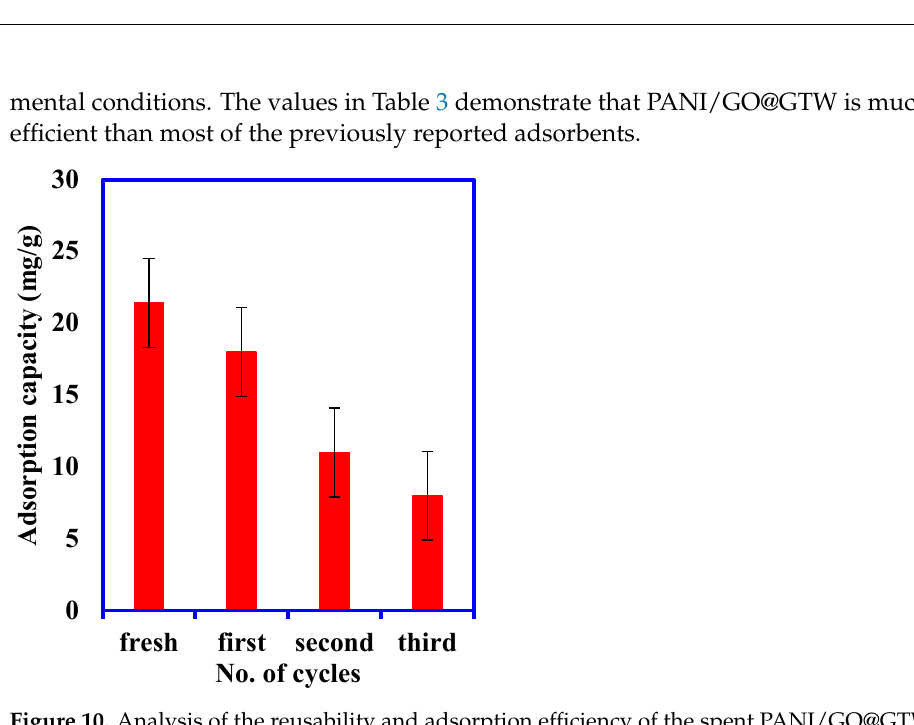
Figure 10. Analysis of the reusability and adsorption efficiency of the spent PANI/GO@GTW.